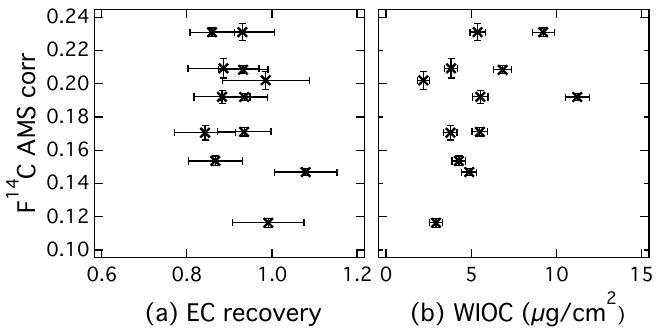
Figure 6. ( a ) F 14 C of EC (AMS correction) measured at CIO plotted versus the EC recovery and ( b ) versus the water-insoluble OC (WIOC) concentration determined with the Sunset OC-EC analyzer (EUSAAR_2 protocol, water-extracted filter).